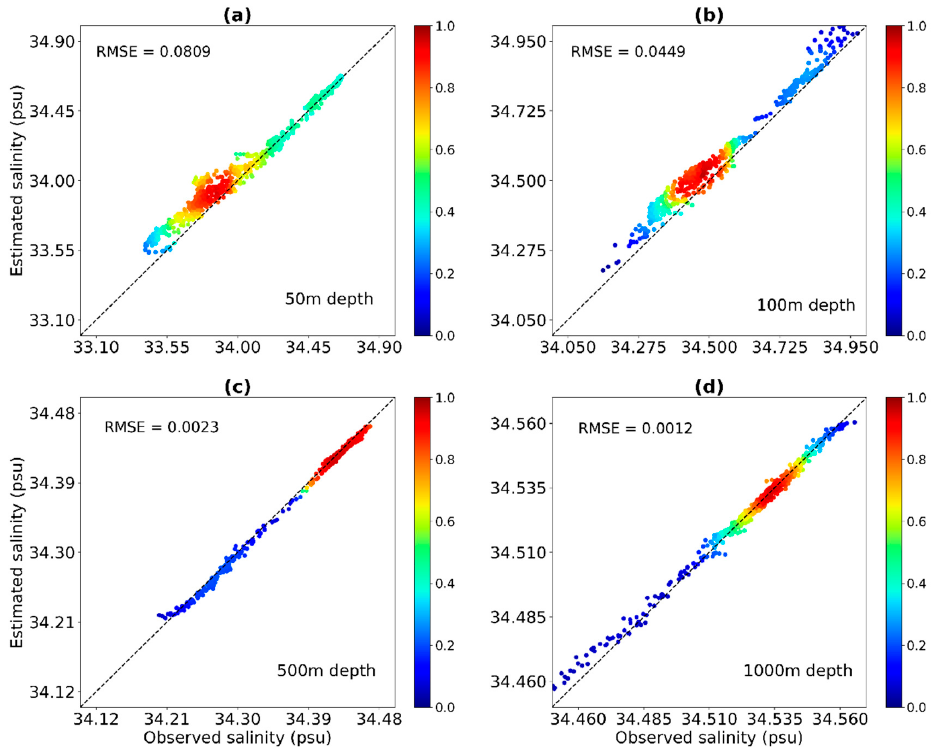
Figure 12. Density scatter plots of the salinity from LGB-DF estimations and Argo observations at